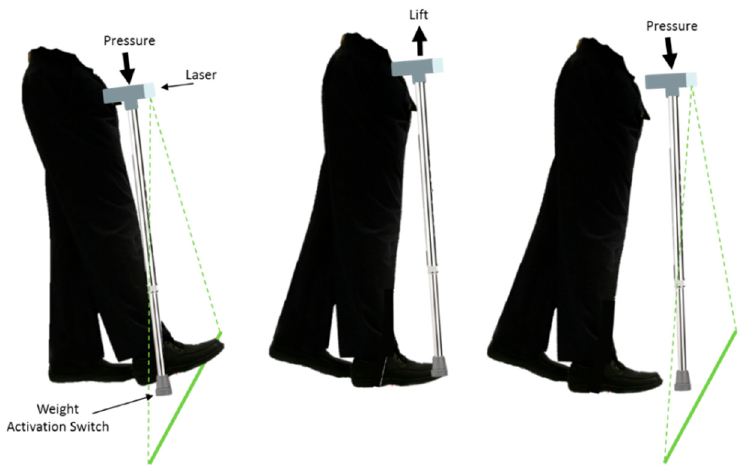
Figure 10. Illustration of the LaserCane, developed at the Chulalongkorn Center of Excellence for Parkinson’s disease and Related Disorders. The LaserCane projected a green laser line on the ground only when pressure was applied to the weight activation switch.